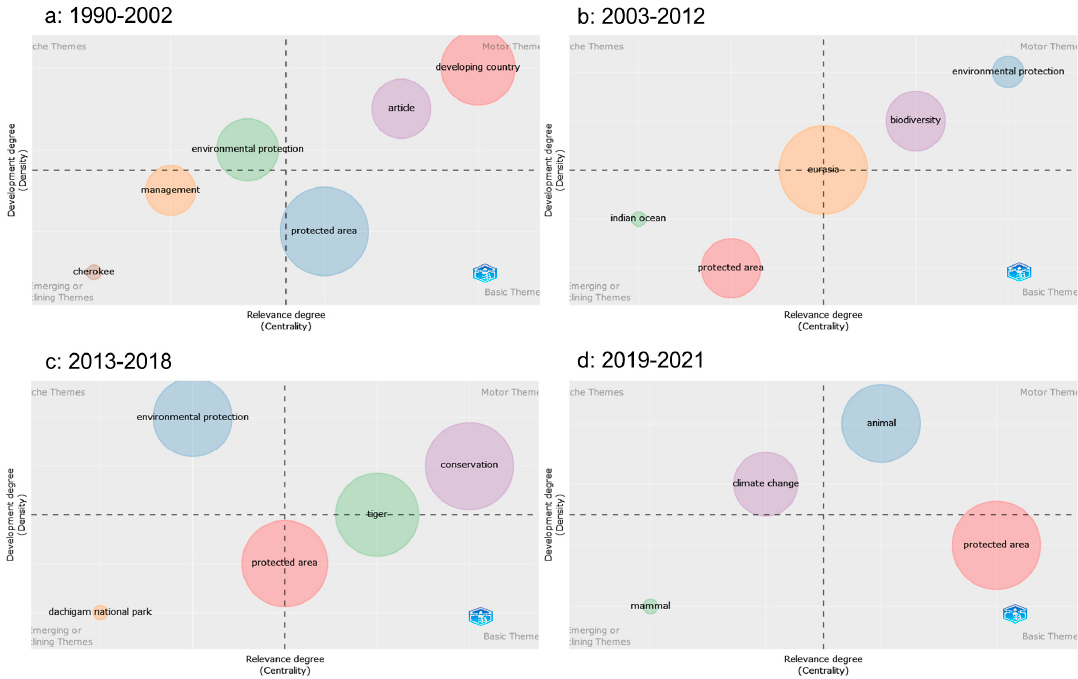
Figure 10a outlines the thematic evolution of the CPAP-related publications. Some